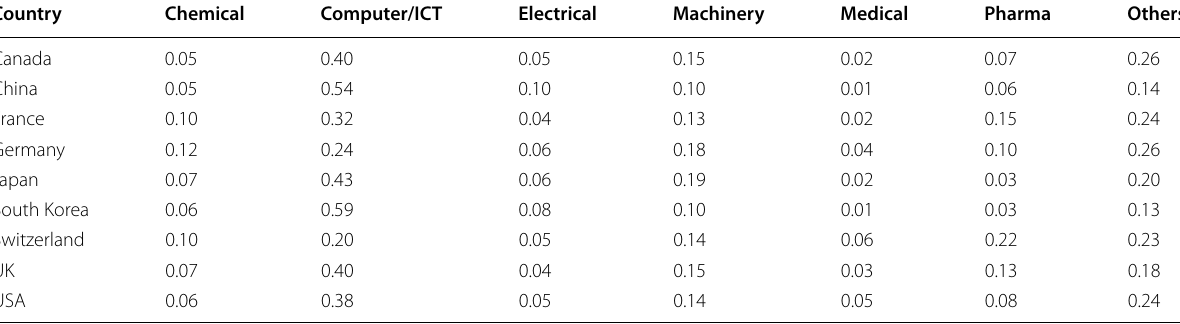
Table 6 Distribution of countries’ patents across